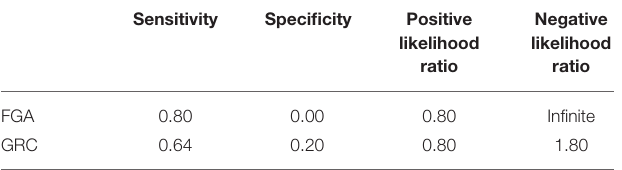
TABLE 3 | Sensitivity specificity, positive likelihood ratio, and negative likelihood ratio of the FGA, and GRC for improvement of gait score in the post-shunt iNPHGS in the mild gait disturbance